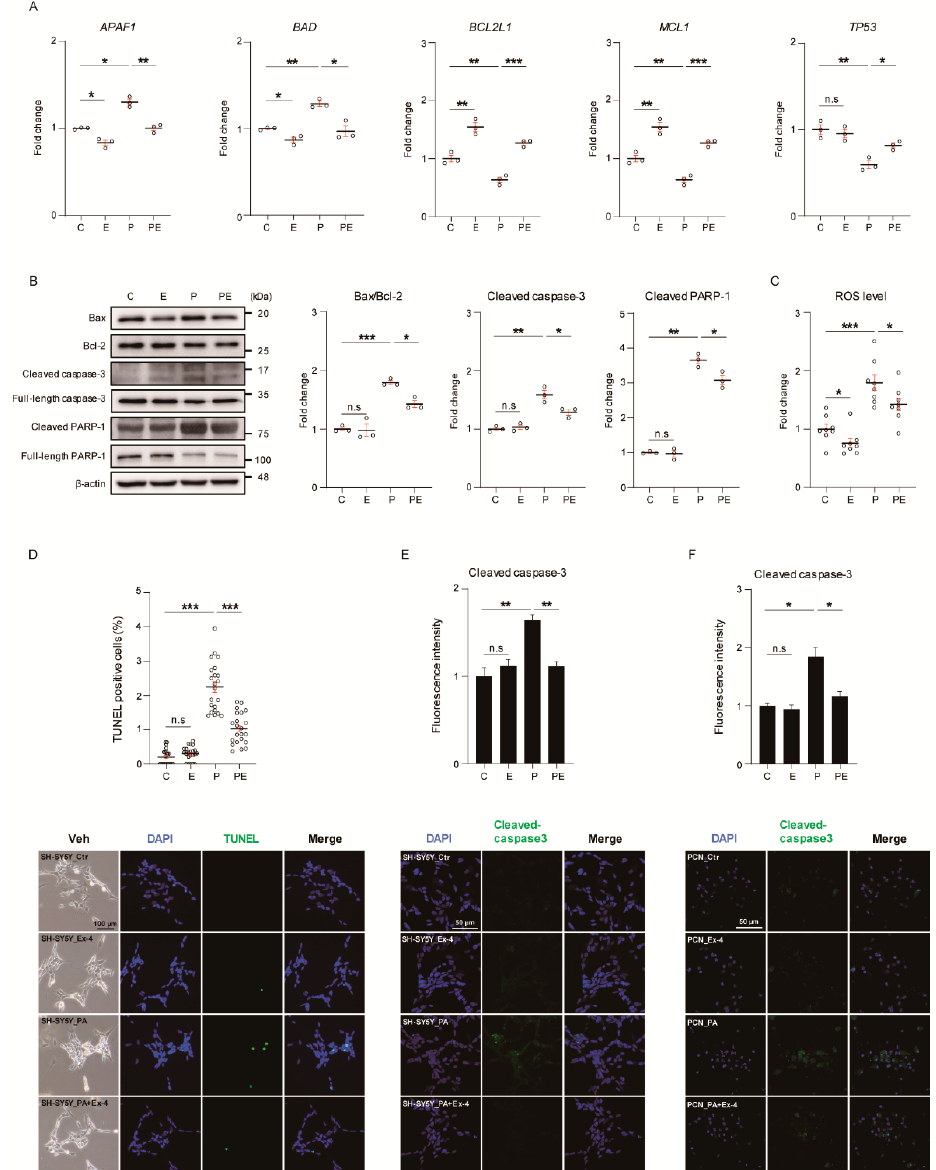
Figure 1. Exendin-4 suppresses the neuronal apoptosis under palmitic acid-induced oxidative stress. ( A ) Comparison of mRNA expression levels of pro-apoptotic ( APAF1 and BAD ) and anti-apoptotic genes ( BCL2L1 , MCL1 , and TP53 ) in SH-SY5Y cells treated with Vehicle (C or Ctr), Exendin-4 (E or Ex-4), Palmitic acid (P or PA), and both Palmitic acid and Exendin-4 (PE or PA+Ex-4). The mRNA level of each gene is normalized to GAPDH level. ( B ) Western blot for the protein level of neuronal apoptosis signaling in SH-SY5Y cells treated with reagents described in ( A ). Each protein level is normalized to β -actin. The cleaved proteins were normalized to each full-length protein. ( C ) Measurement of ROS level stained with DCF-DA (100 µ M) in SH-SY5Y cells treated with reagents described in ( A ). ( D ) Detection of PA-induced apoptosis by transferase dUTP nick end labeling (TUNEL) assay in SH-SY5Y cells treated with reagents described in A. Nuclei were counterstained with DAPI (blue), and apoptotic cell stained with TUNEL (green). The percentage of TUNEL positive cells of each group is normalized to the vehicle (control) group; >100 cells per group were analyzed. Scale bar: 100 µ m. ( E , F ) immunocytochemistry images of cleaved caspase-3 expression in SH-SY5Y and primary cortical neuron (PCN) neurons at day 7 in vitro (DIV 7) treated with reagents described in A. Nuclei were counterstained with DAPI (blue), and apoptotic cell stained with cleaved caspase-3 (green), >100 ( E ) and >50 ( F ) cells per group were analyzed. Scale bar: 50 µ m. Data information: SH-SY5Y cells were treated with 10 nM of Exendin-4 and 50 µ M of palmitic acid per group, according to the treatment plan (Figure S1B,C). In ( A – F ), error bars represent S.E.M. from three independent experiments. n.s p > 0.05, * p < 0.05, ** p < 0.01, *** p < 0.001 (unpaired two-tail t -tests with Welch’s